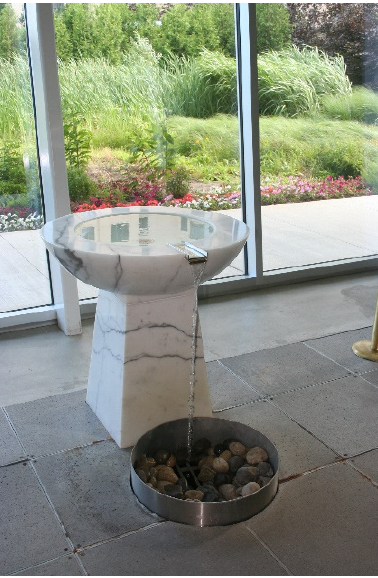
Figure 6. Baptismal font placed in front of the window overlooking the garden (Credit: Roberto Chiotti).